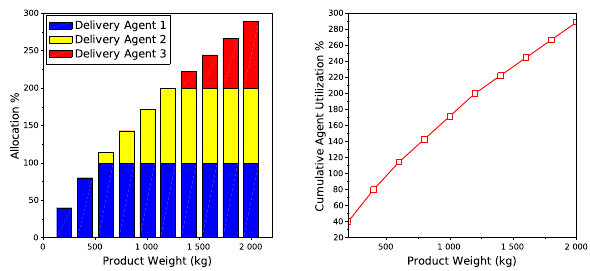
Figure 4. Allocation Ratio to Agents and Utilization Levels.